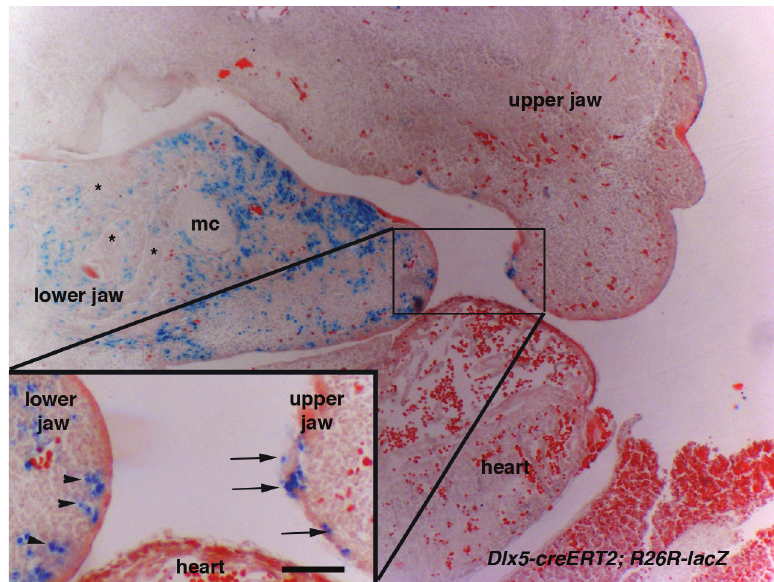
Figure 3. Derivatives of Dlx5 -expressing progenitors in the upper and lower jaw primordia. Sagittal section of Dlx5-creERT2; R26R-lacZ through the cephalic region of a 12.5dpc/Theiler stage 22 (ts22) mouse embryo. The pregnant dam was treated with tamoxifen at 7dpc/ts9. β -Galactosidase activity is found in CNCCs derivatives of the lower jaw (arrowheads). In contrast, in the upper jaw positive cells are only present in the overlying epithelium (arrows). mc, Meckel’s cartilage; asterisks, lower jaw muscles. Scale bar 50µm in insert, 150µm in the main